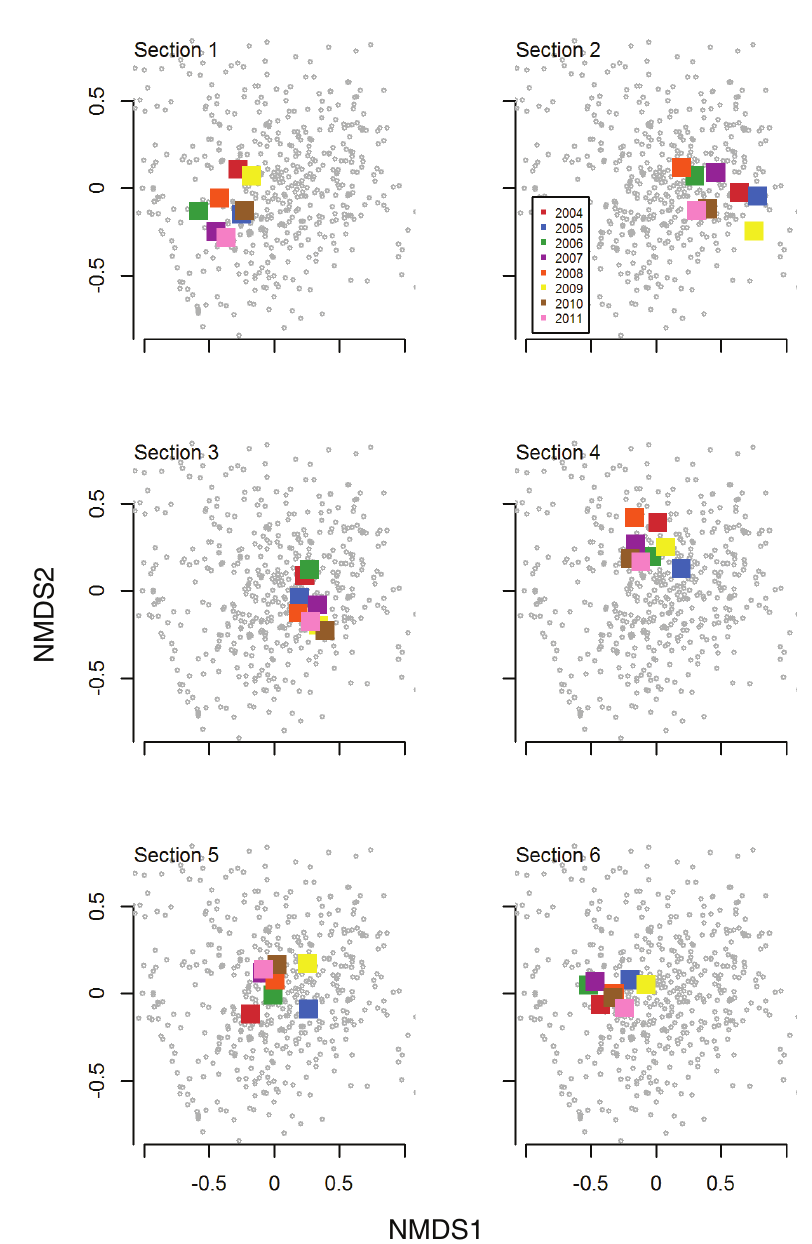
Figure 5. Final NMDS illustrating average community ordination location of section by year. Illustrates where the section exists in the overall ordination space and how that position changes through the study period. The gray symbol represent the site locations- as were presented in Figure 4. In other words, all Figure 5 subplots are constructed from the NMDS presented above. Here we have added the average position for each section (based on all sites within that section) by